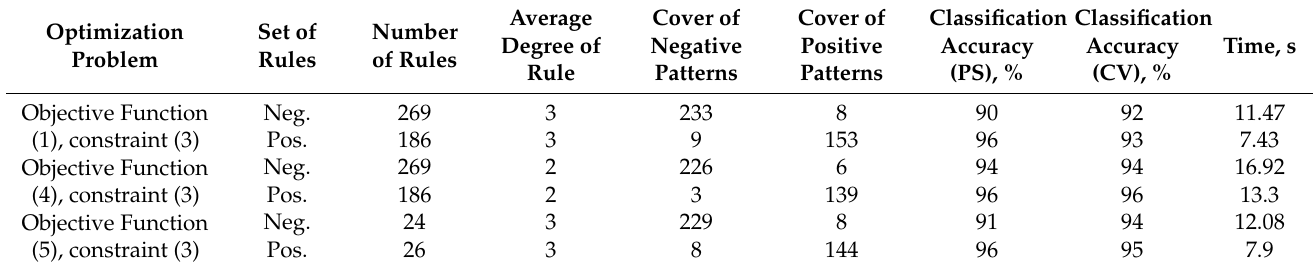
Table 1. Classification results for the problem of breast cancer diagnosis.